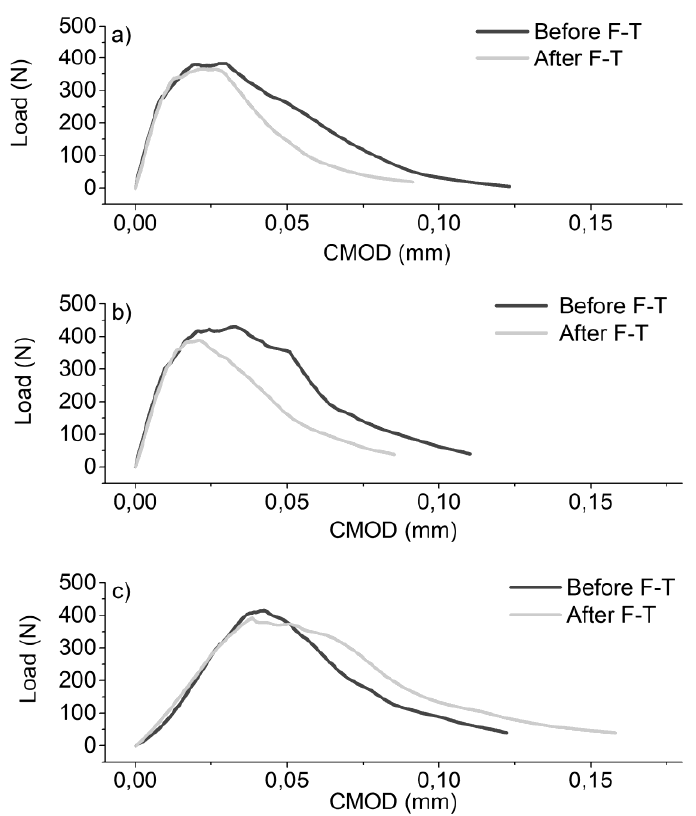
Figure 6. Load-crack mouth opening displacement (CMOD) graphs of unmodified ( a ) and 0.6% nano-modified mortars prepared with ( b ) superplasticizer and ( c ) surfactant as a dispersive agent, as a function of F-T exposure.